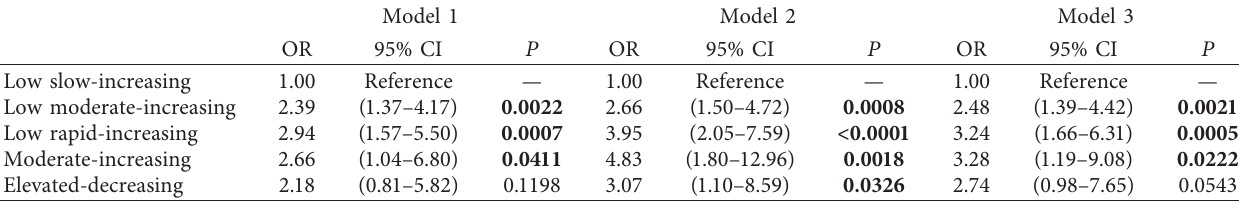
Table 3: Associations between BMI trajectories and adult